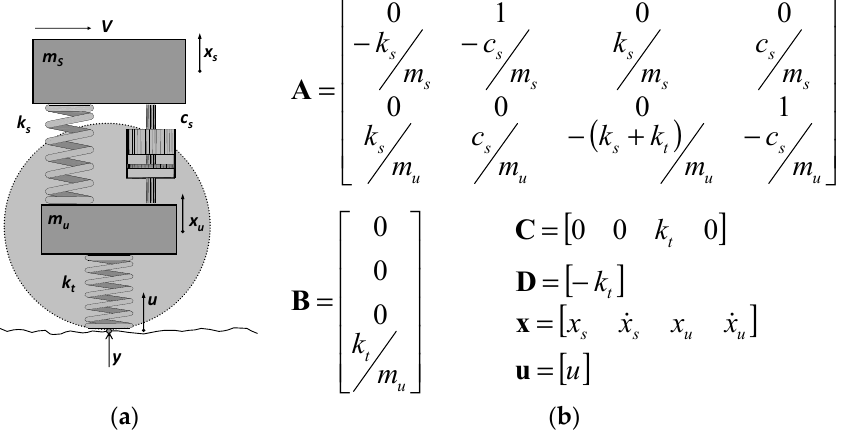
Figure 11. Scheme of ( a ) the quarter-truck model and ( b ) the matrices used in the state-space model in MATLAB.